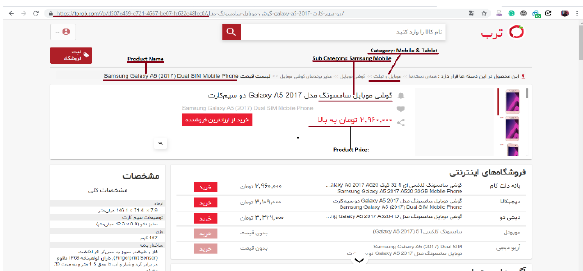
Figure 2(b) An overview of the website for the specific webpage link